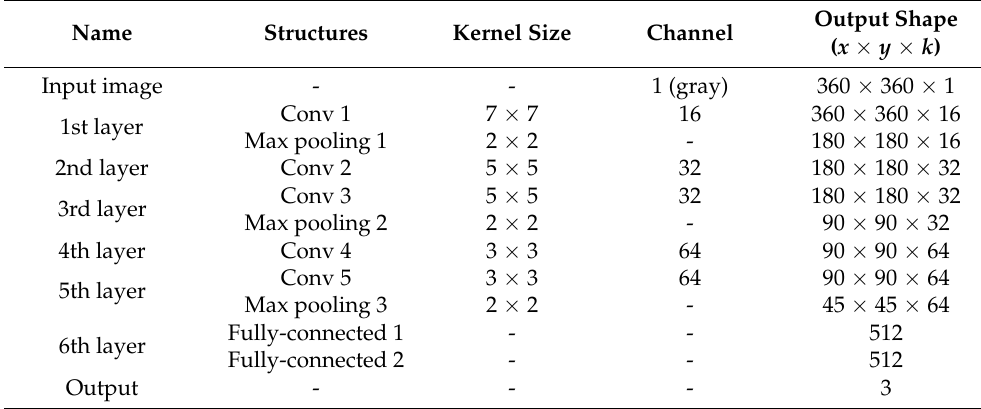
Table 6. Architecture of the solar cell CNN. Adapted with permission from ref. [16].